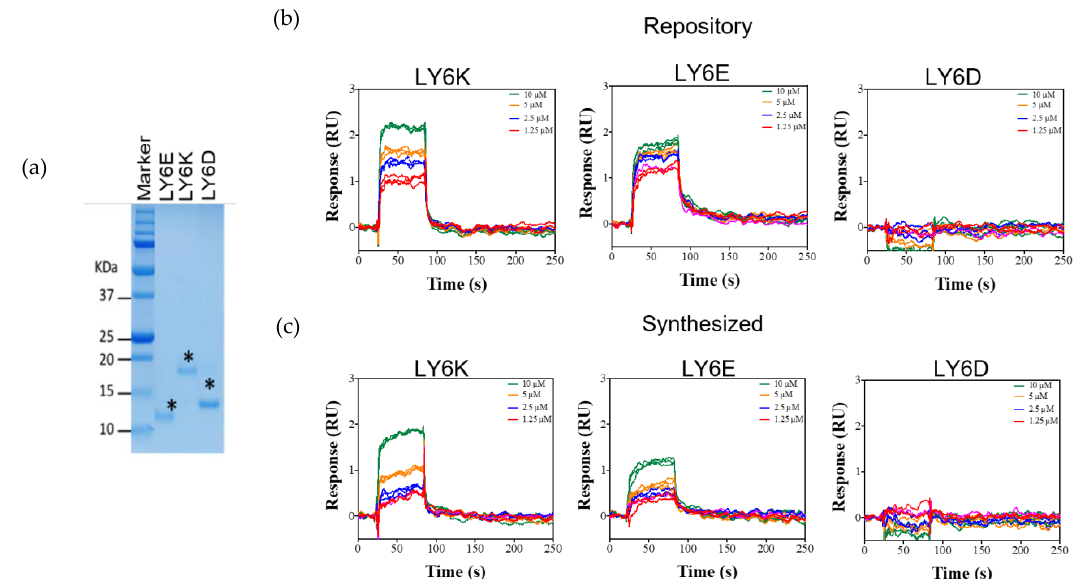
Figure 4. NSC243928 specifically binds to the mature form of LY6K. ( a ) The mature forms of LY6E, LY6D, and LY6K were cloned in pET24a N-term His-tag vector (Epoch Biosciences); expressed in BL21DE Escherichia coli ( E. coli ); purified using Ni-NTA resin; run on the 15% SDS-PAGE gel. The ‘*’ shows the specific LY6 protein bands of expected molecular weights. ( b , c ) Representative SPR sensorgrams for NSC243928 binding to LY6K, LY6E, and LY6D. NSC243928 shows a dose-dependent binding response to LY6K, whereas non-specific/no binding was observed for LY6E/LY6D, respectively; ( b ) NSC243928 obtained from NCI repository, ( c ) NSC243928 synthesized at USC.